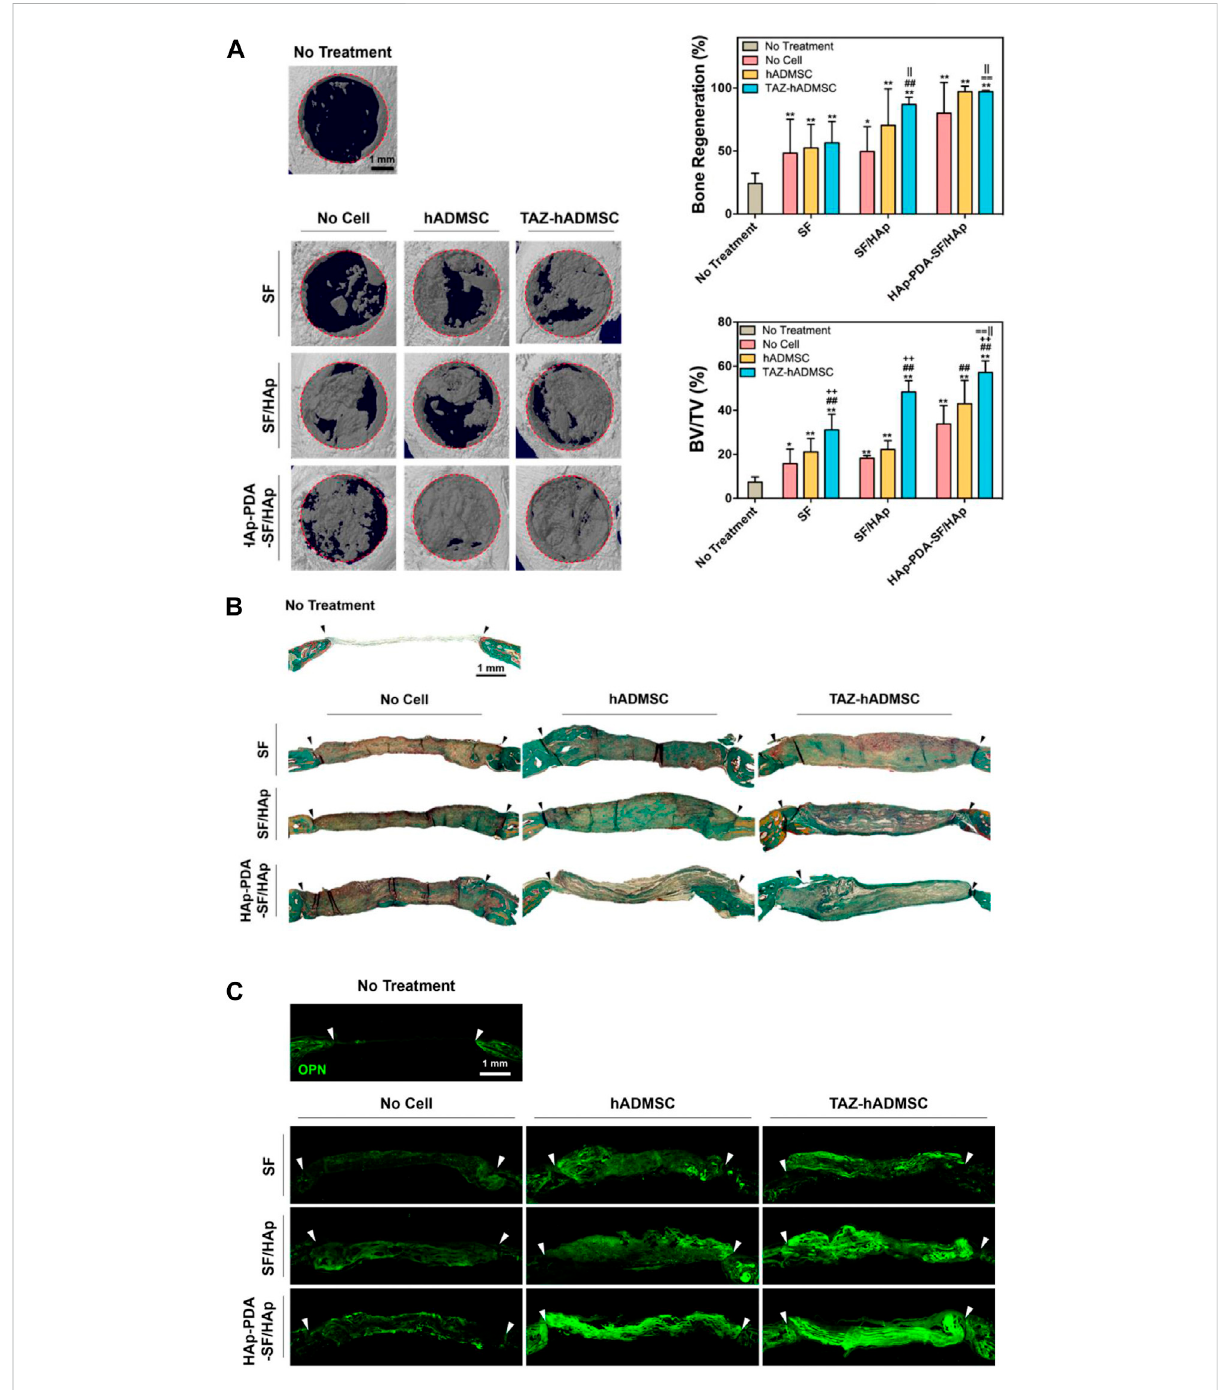
FIGURE 3 In vivo evaluation of the HAP-functionalized SF scaffolds. (A) 3D images of the regenerated calvarial defects treated by different scaffolds and quantitative evaluation. (B) Goldner ’ s trichrome staining of regenerated calvarial defects. (C) Osteopontin immuno fl uorescence staining